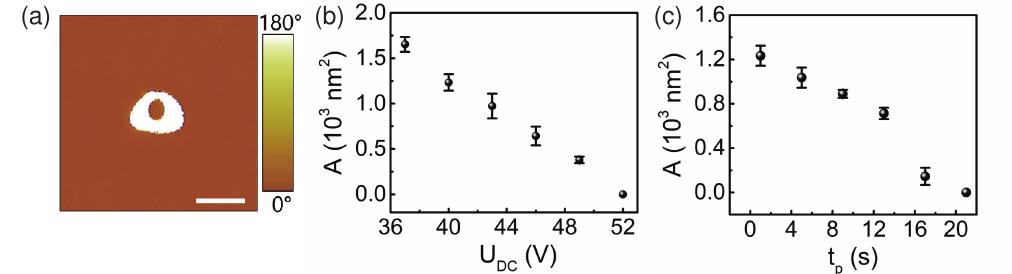
Figure 2. ( a ) is the PFM image of a donut-shaped domain produced with an AFM tip voltage of U DC = 40 V and t p = 1 s. ( b , c ) depict the dependence of the inner domain area A on the magnitude U DC and the pulse duration t p of the tip voltage, respectively. The corresponding pulse duration and magnitude of the tip voltage were set to be t p = 1 s in ( b ) and U DC = 40 V in ( c ), respectively. Scale bar: 100 nm.